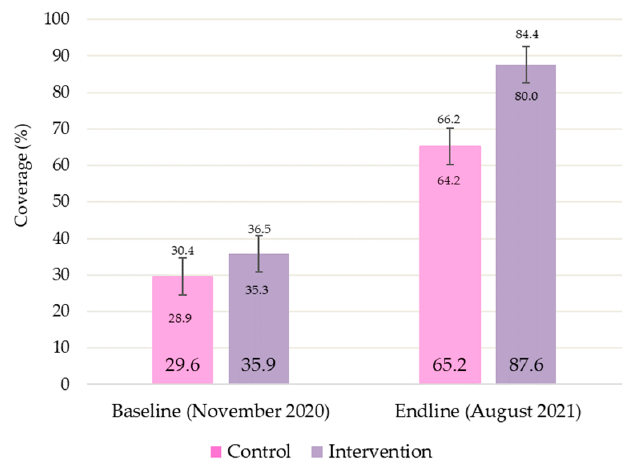
Figure 2. Baseline and endline coverage assessment of non-complicated severe acute malnutrition treatment compared by study groups. Table 3. Characteristics of cases at admission for severe acute malnutrition treatment, compared by study